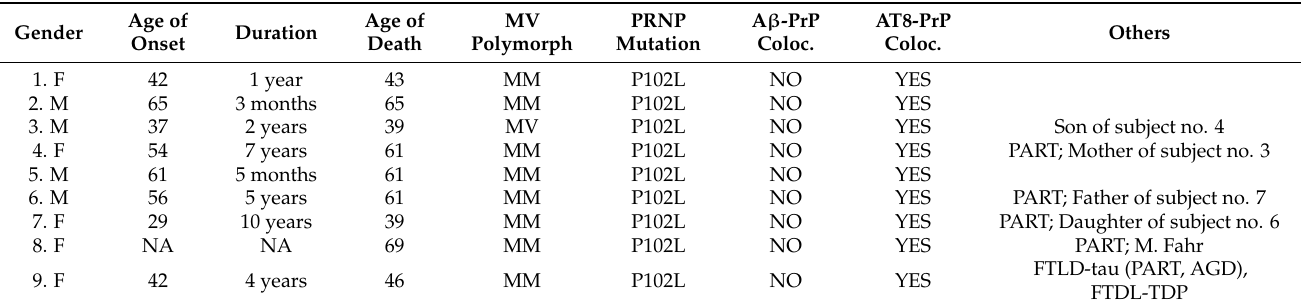
Table 1. Summary of information for a Czech cohort of clinically, neuropathologically, and genetically confirmed Gerstmann– Sträussler–Scheinker syndrome, all having the P102L mutation in the PRNP gene.